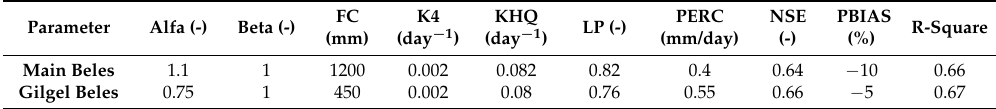
Table 1. HBV model calibrated parameters and model performance for the Main and Gilgel Beles